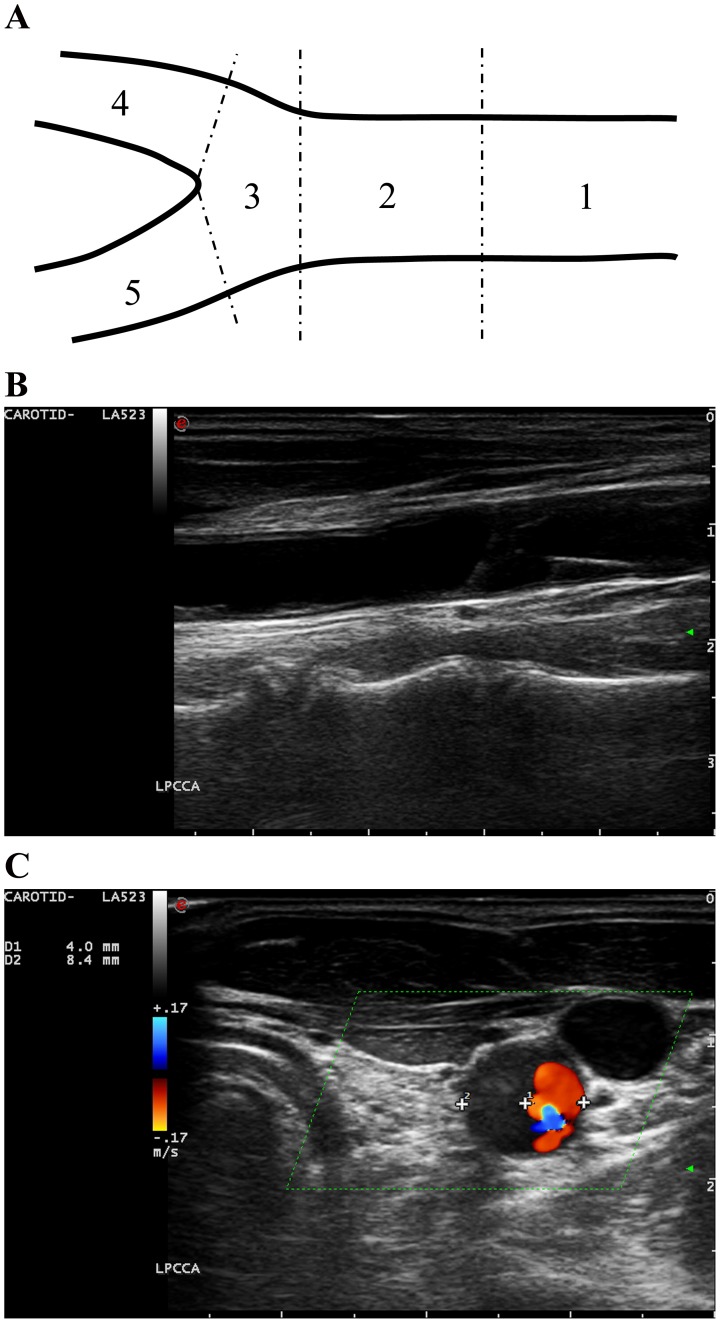
Assessment of carotid plaque burden.
A). Five segments of the extra-cranial carotid artery: 1. proximal common carotid artery (≥2 cm proximal to carotid bifurcation); 2. distal common carotid artery (<2 cm proximal to carotid bifurcation); 3. carotid bulb and bifurcation; 4. internal carotid artery; and 5. external carotid artery. B). A longitudinal gray-scale image of a carotid plaque in the proximal common carotid artery. C). A transverse duplex ultrasound (gray-scale+Doppler) image of the carotid plaque in B. The plaque is echolucent with a unclear boundary between the lumen and the plaque. Therefore, Doppler ultrasound is applied to demonstrate the lumen at the stenosis. The degree of the carotid stenosis is expressed as the percentage reduction of lumen diameter (1-D1/D2 = 52.4%). Carotid plaque score is the summation of the degree of carotid stenosis of the five segments in both carotid arteries.